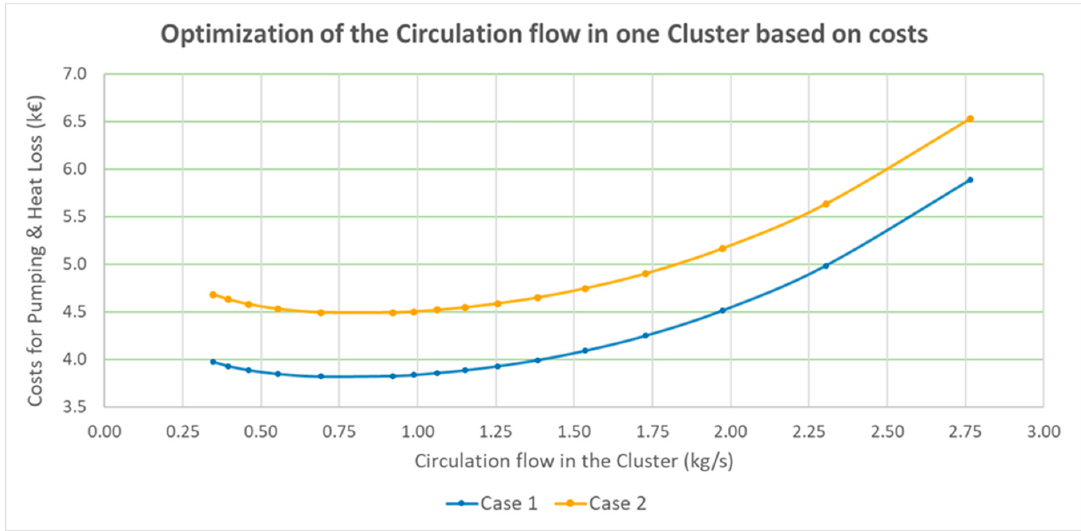
Figure 12. Optimal summer circulation flow in the cluster.